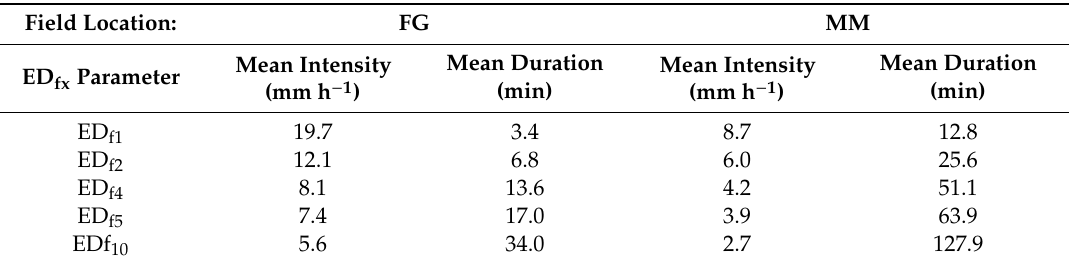
Table 2. Rainfall intensity and rain duration for ED f1 to ED f5 (event duration fraction, 1%–5%), for the Fowlers Gap Arid Zone Research Station in New South Wales (FG) and Millaa Millaa on the Atherton Tableland in far northern Queensland (MM) field